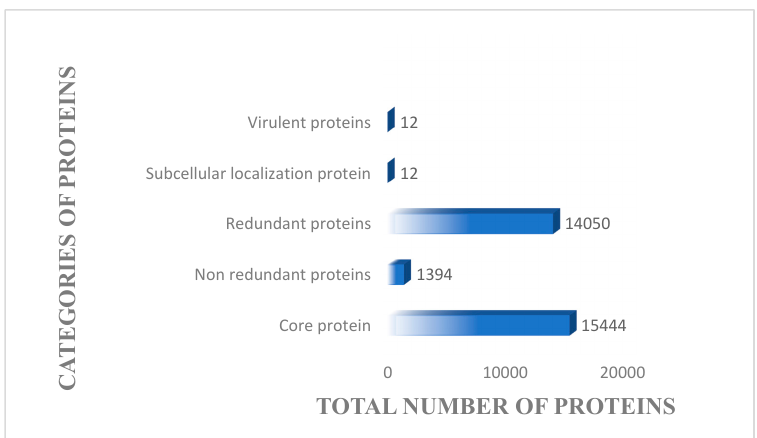
Figure 3. A pan ‐ phylogenetic tree of the genome of S. auricularis . Figure 3. A pan-phylogenetic tree of the genome of S. auricularis .